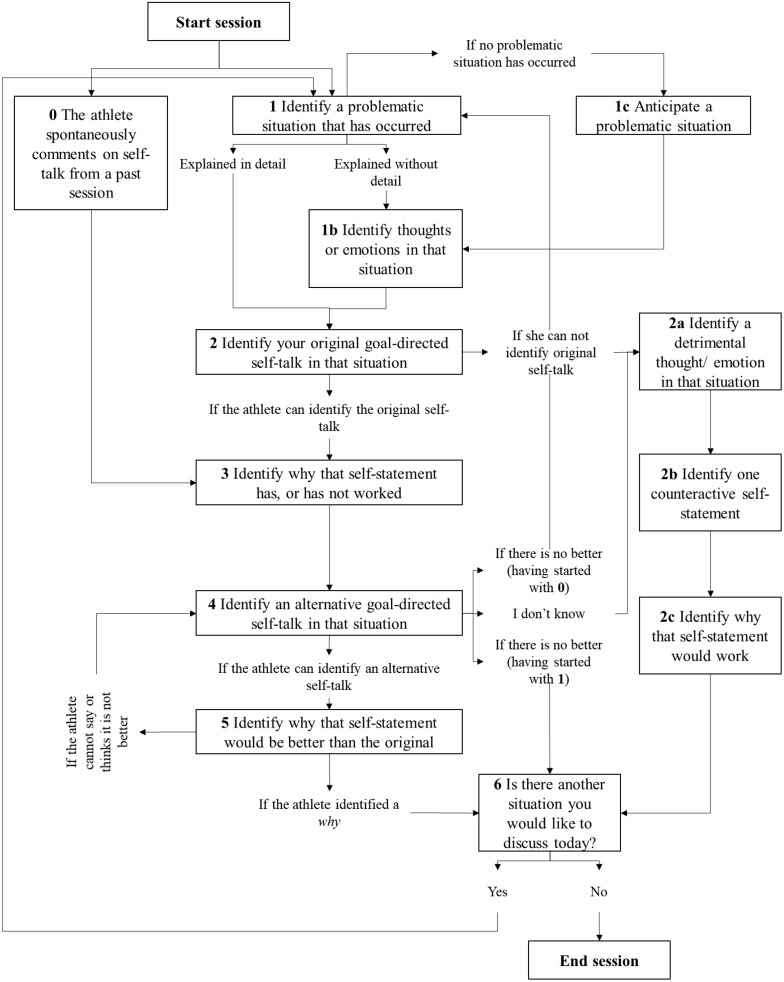
Flow chart representing the protocol in the reflexive self-talk online intervention for a single session.